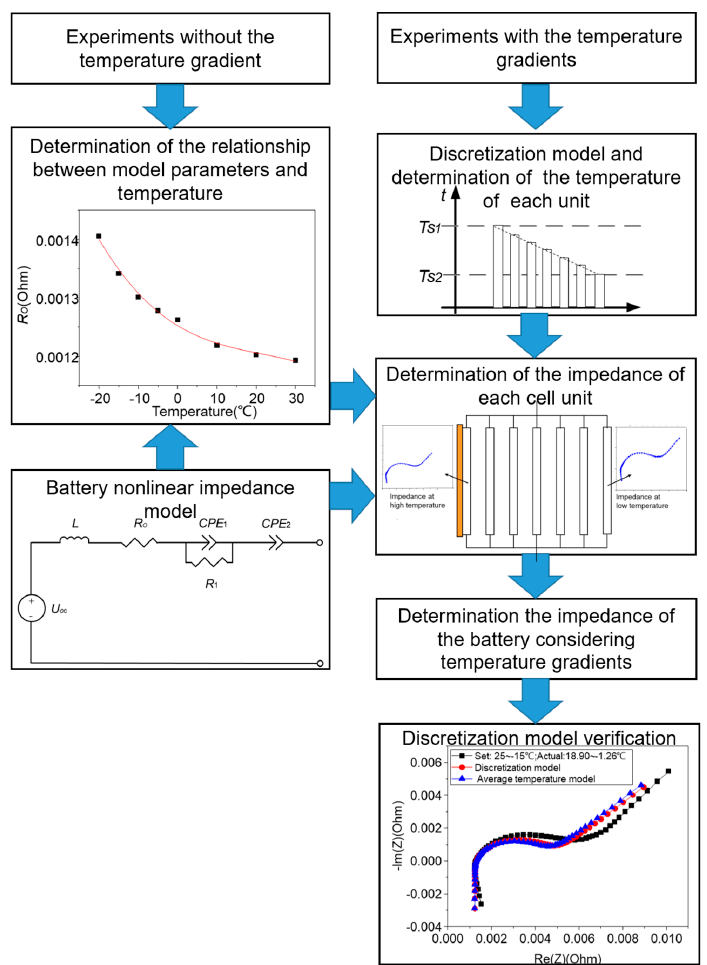
Figure 5 . Flowchart of the discretization modeling of a battery. Figure 5. Flowchart of the discretization modeling of a